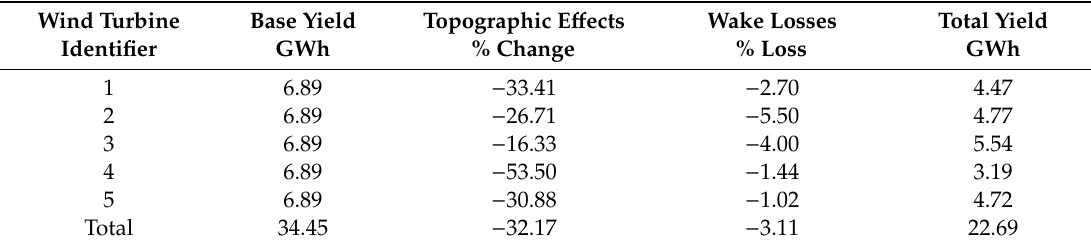
Table 5. Wind farm energy yield for the wind farm layout.